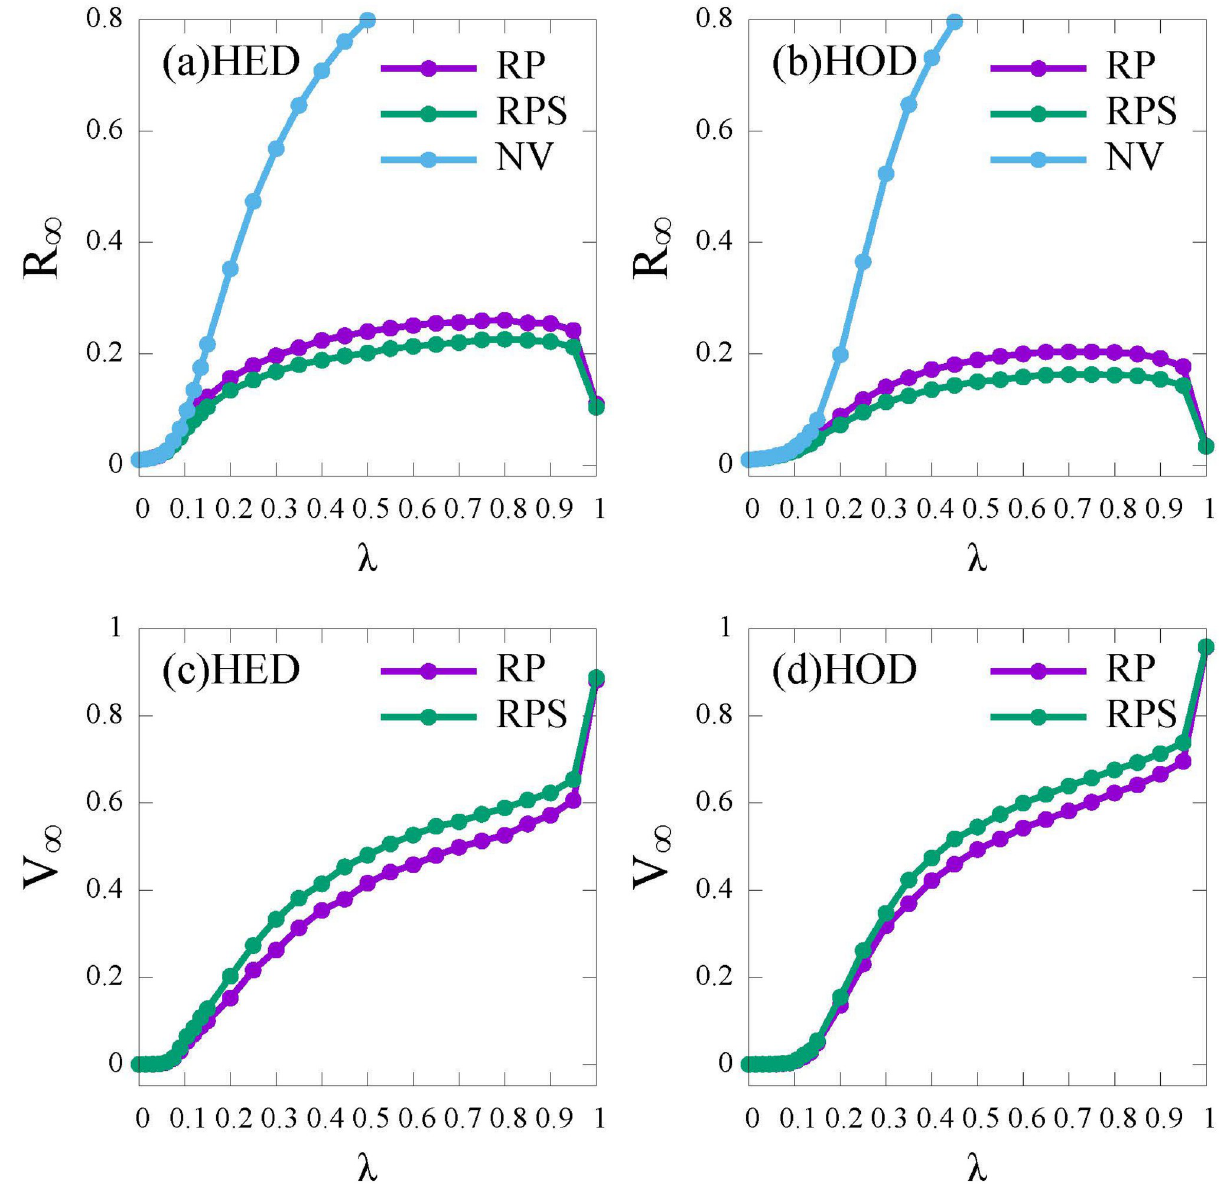
Fig 4. The final epidemic size ( R 1 ) and the vaccine coverage ( V 1 ) as functions of λ under different vaccination strategies. No vaccination (NV, blue); the risk perception vaccination strategy (RP, purple); the risk perception with subsidy policy vaccination strategy (RPS, green). (a) and (c): HED network; (b) and (d): HOD network. Here the relative cost c =